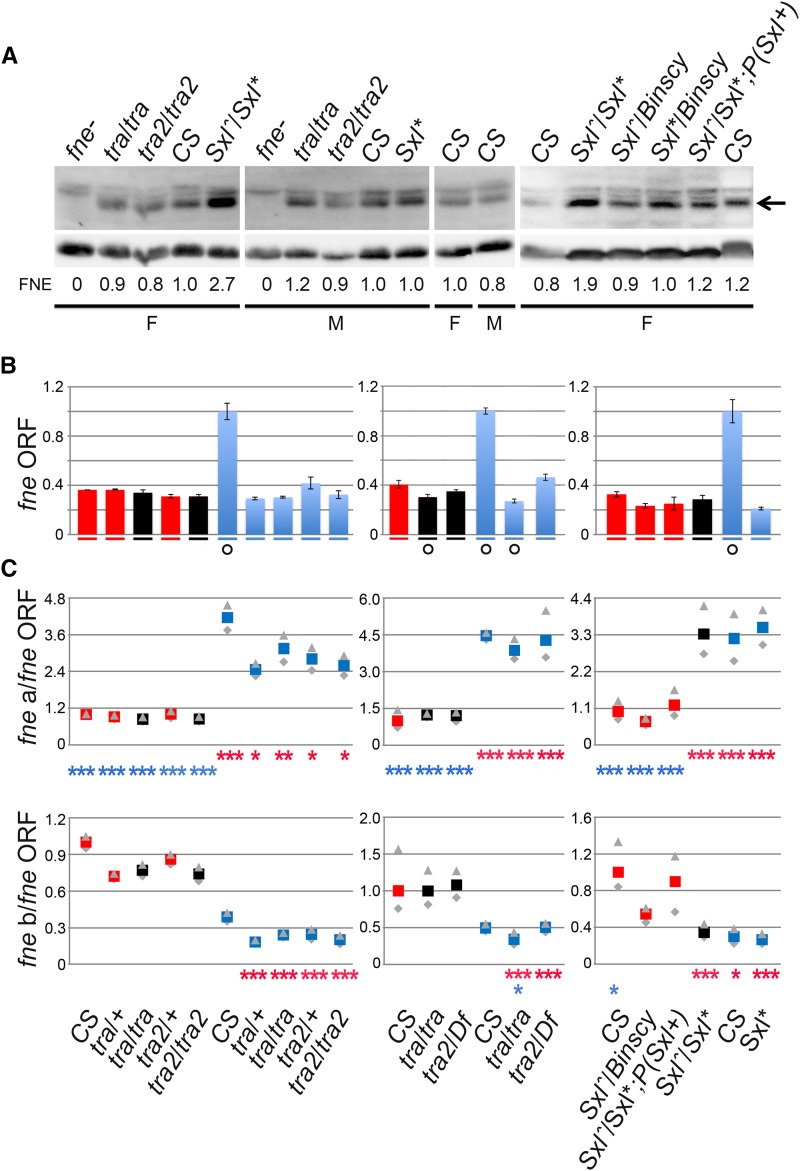
Impact of tra, tra2, and Sxl mutations on the expression of FNE protein and fne ORF-containing transcripts. (A) Immunoblot analysis of head protein extracts with anti-FNE antibodies. Tubulin is used as a loading control. Genotypes are as in Figure 2 and Figure 3. Head protein extracts were prepared from sibling flies born from the same parents and collected at the same time as the flies used for the head RNA preparations. An arrow indicates the position of FNE protein on the blots. The quantification of relative amounts of FNE is shown below the blots. (B) Quantitation of the amount of fne ORF. Genotypes and RNA batches used in this experiment are the same as those used for Figure 3. Each set of bar plots shows the female (red), pseudomale (black), and male (blue) relative transcript levels (determined by qPCR). Symbols summarizing the conclusions of ANOVA [F(4, 22)=107.85, P ≤ 1E-5 for the experiment with tra and tra2 mutants, F(2, 18)=217.66, P ≤ 1E-5 for the experiment with tra, tra2, and Df(2R)trix, F(5, 18)=108.39, P ≤ 1E-5 for Sxl as detailed in File S2] followed by post hoc test are as in Figure 3. (C) Enrichments (defined in Figure 2) of fne-a (and, respectively, fne-b) relative to ORF-containing fne transcripts are shown below the bar plots using the same symbols as in Figure 3, and as detailed in File S3.